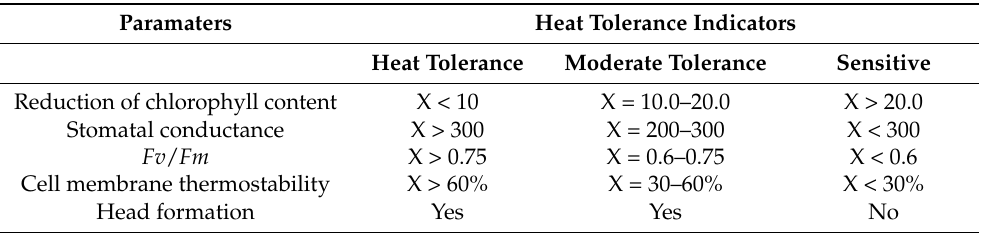
Table 1. A summary of physiological and morphological parameters evaluated in this study can be used as indicators for the selection of heat tolerance in